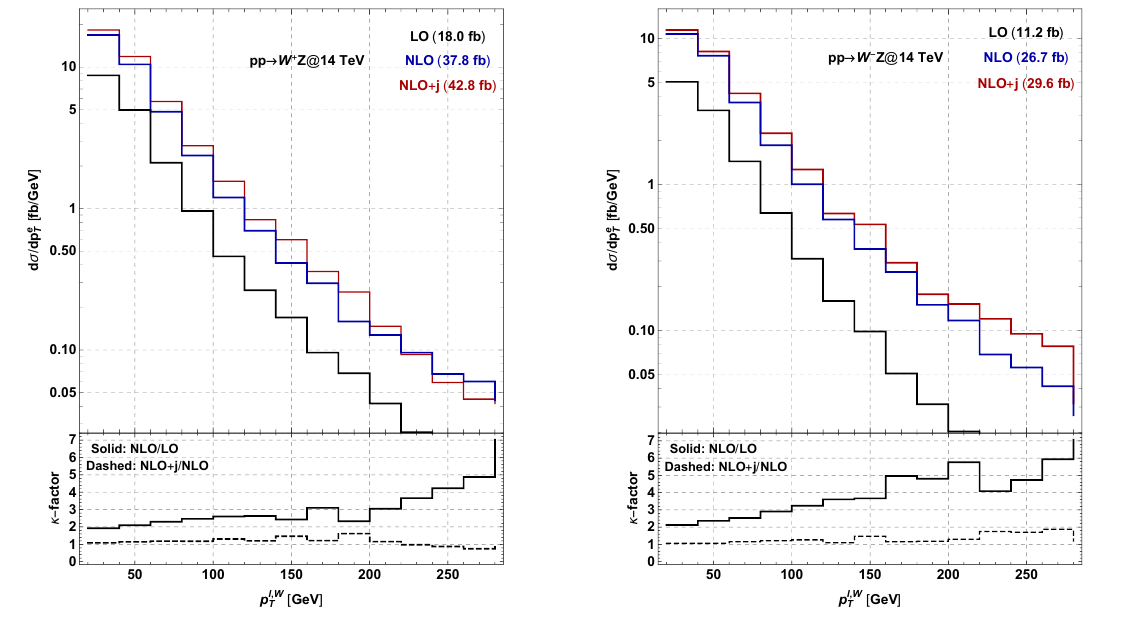
Figure 2 . Di(cid:11)erential distributions in function of the transverse momentum of the lepton arising from the W + (left) and W (cid:0) (right) decay at the LO, NLO and NLO+ j accuracy for the SM fully leptonic pp ! W (cid:6) Z process. In the lower panels we show the NLO/LO and NLO+ j /NLO di(cid:11)erential cross section